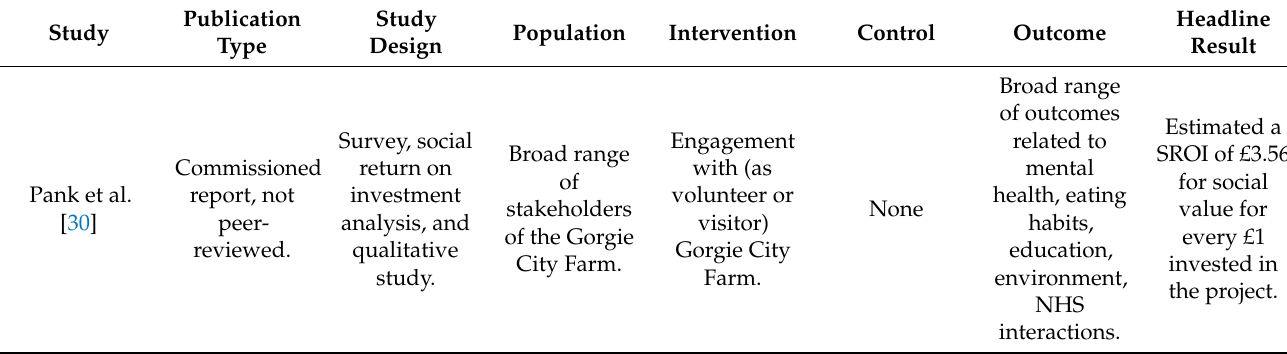
Table 1. Table of studies that conducted primary data collection relevant to any of the five